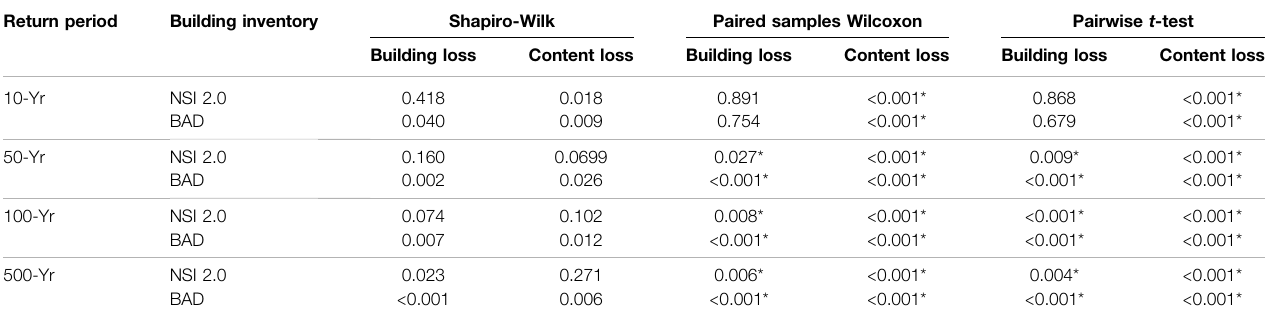
TABLE 9 | p -values of Shapiro-Wilk normality test (with values < 0.05 representing a non-normal distribution) for the distribution of differences between NSI 2.0- and BAD- generatedbuildingandcontentlosses,andpairedsamplesWilcoxonandpairwise t -test(withsigni fi cantdifferencesat p < 0.05denoted byanasterisk)ofdefaultDDFin Hazus Level 2 (which is the same as the default DDF in FAST) vs HEC-FIA as input in the Hazus Level